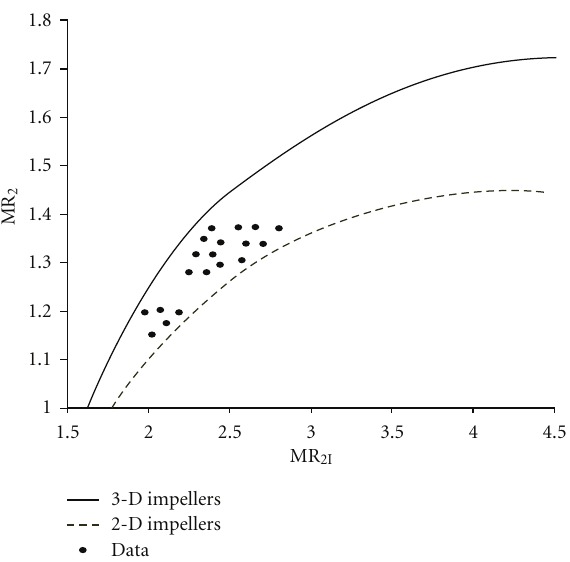
Figure 10: Relationship of MR 2 versus MR 2 I .